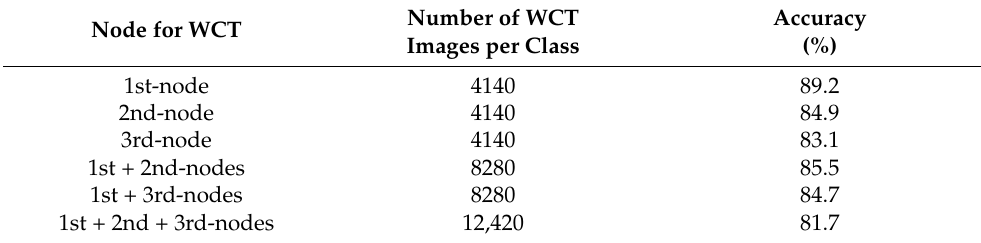
Table 2. Performance of proposed CNN for binary classification using WCT of significant node(s) as the input images, where the number of subjects is ASD = NC = 36. Number of Node for WCT